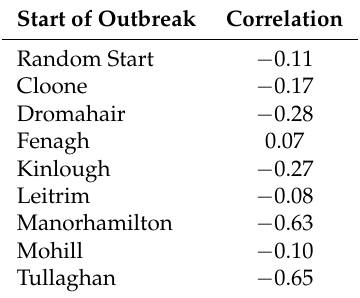
Table 13. Correlations between the percent of runs that lead to an outbreak and the closeness centrality of the town by starting location of the